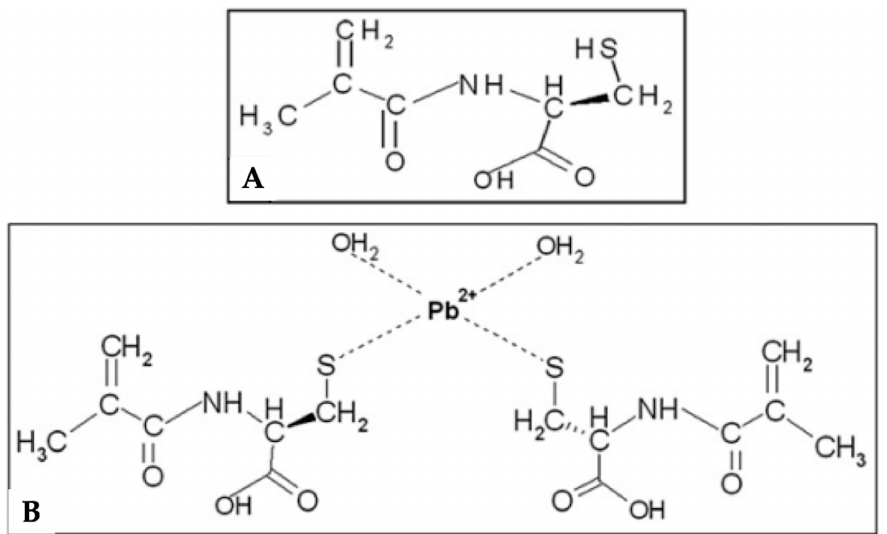
Figure 3. Scanning electron microscope images of ( A ) cadmium (II)-imprinted, ( B ) nonimprinted, ( C